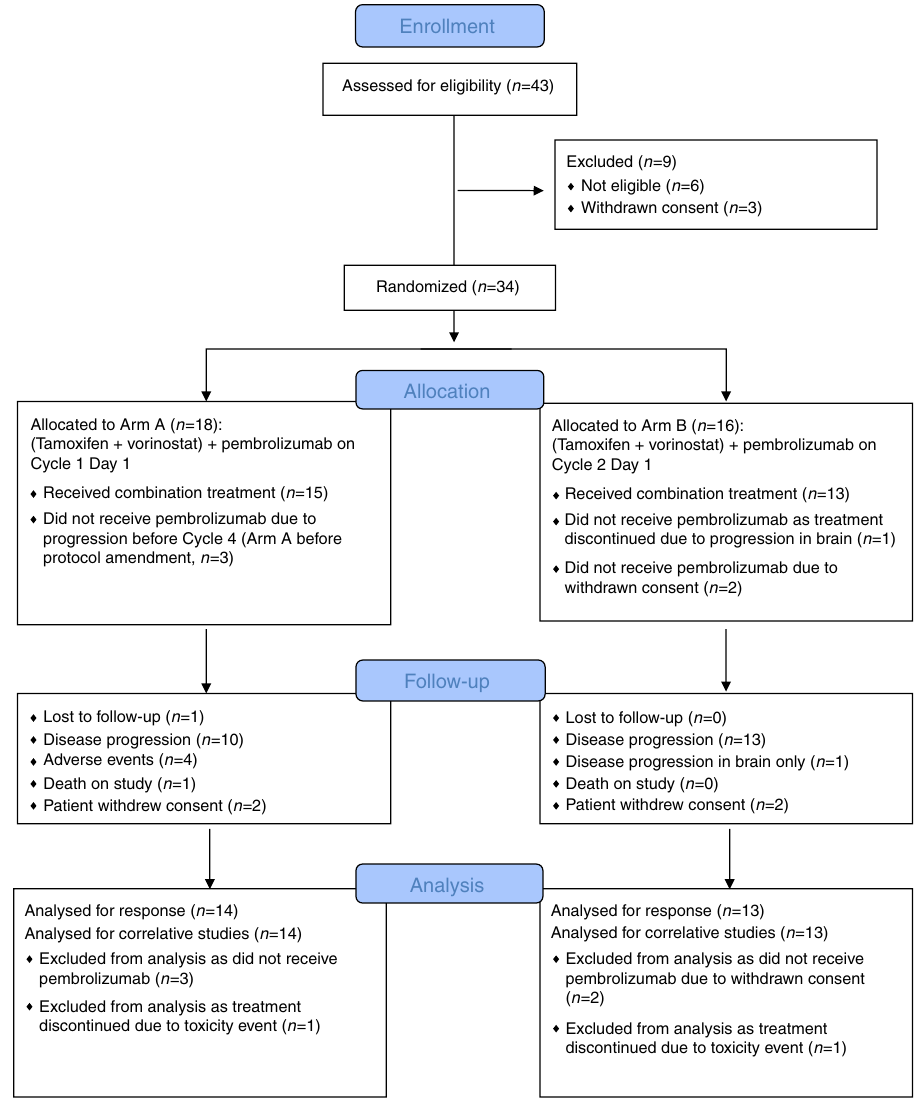
Fig. 1 CONSORT Flow diagram of the randomized prospective phase II clinical trial. The consort fl ow diagram shows the randomization procedures and the description of the two treatment arms of this trial, adding pembrolizumab to tamoxifen and vorinostat either on cycle 1 day 1 or on cycle 2 day